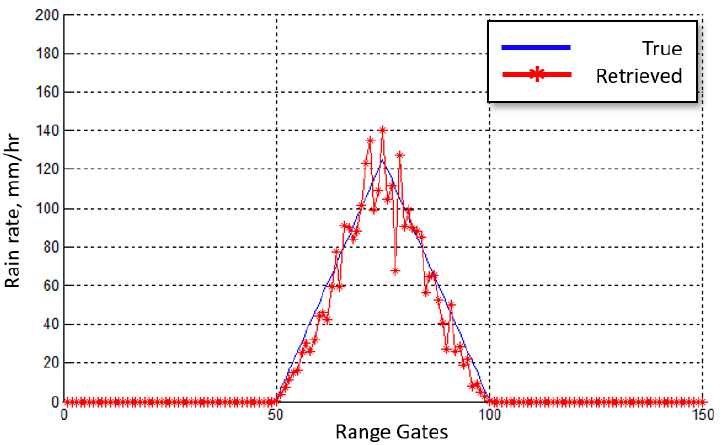
Figure A1. Simulated triangular rain profile with a maximum rain at 125 mm h − 1 . The blue is the simulated rain profile, while the red is the retrieved rain rates using the SFR3 algorithm (single random noise trial).